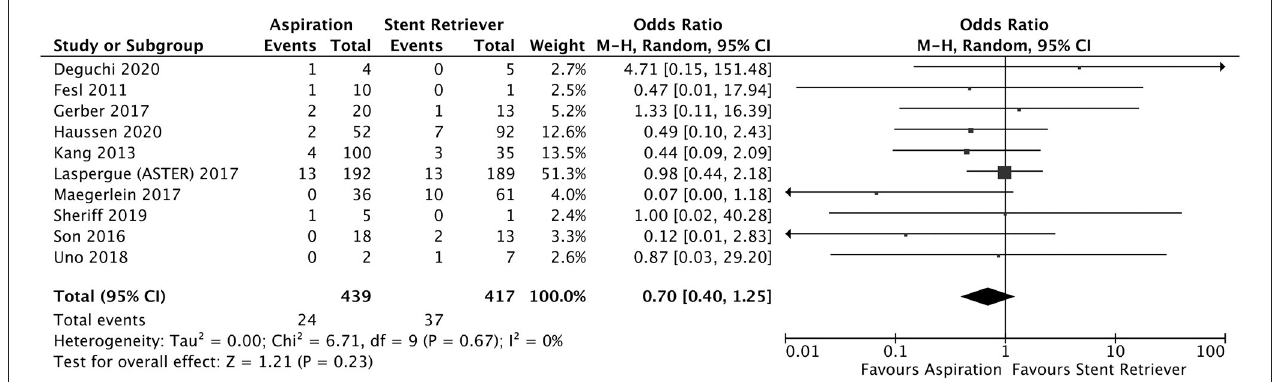
FIGURE 6 | Effect of direct aspiration vs. stent retriever use on subarachnoid hemorrhage following mechanical